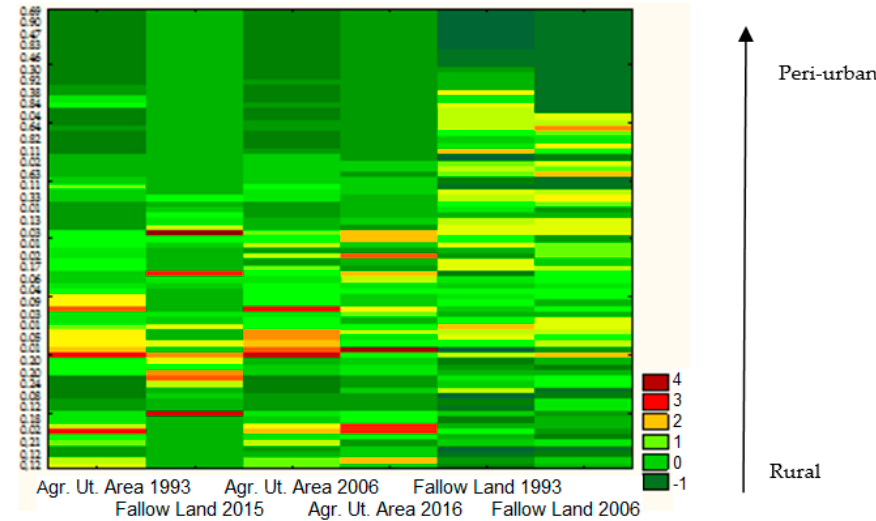
Figure 4. Results of two-way clustering by land-use indicators (columns) and municipalities (rows); the left rank indicates the share of built-up areas in total landscape for each municipality of the study area (colors illustrate the standardized value for each variable according to the legend on the right side of the graph).